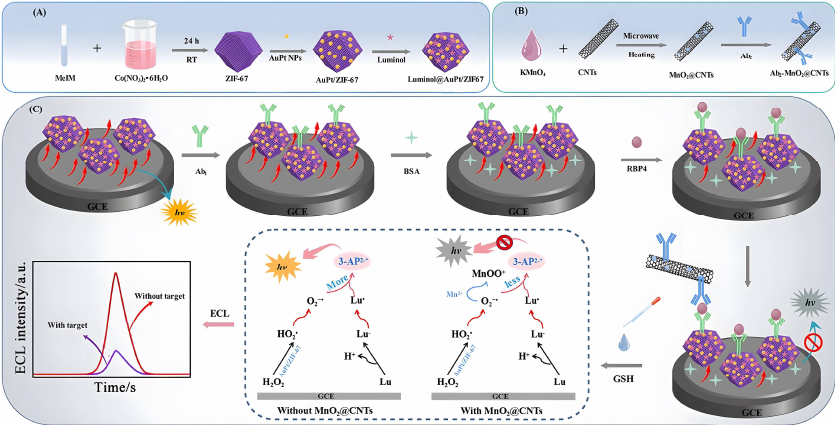
Figure 4. Principle of the dual-quenched ECL immunosensor based on luminol@AuPt/ZIF-67 and MnO2@CNTs for the detection of RBP4. ( A ) The preparation procedure of the luminol@AuPt/ZIF-67. ( B ) The synthesis route of Ab 2 -MnO 2 @CNTs. ( C ) The detection process and operation mechanism of the sandwich-type immunosensor. Reproduced with permission [59]. Copyright 2021, Journal of Nanobiotechnology .